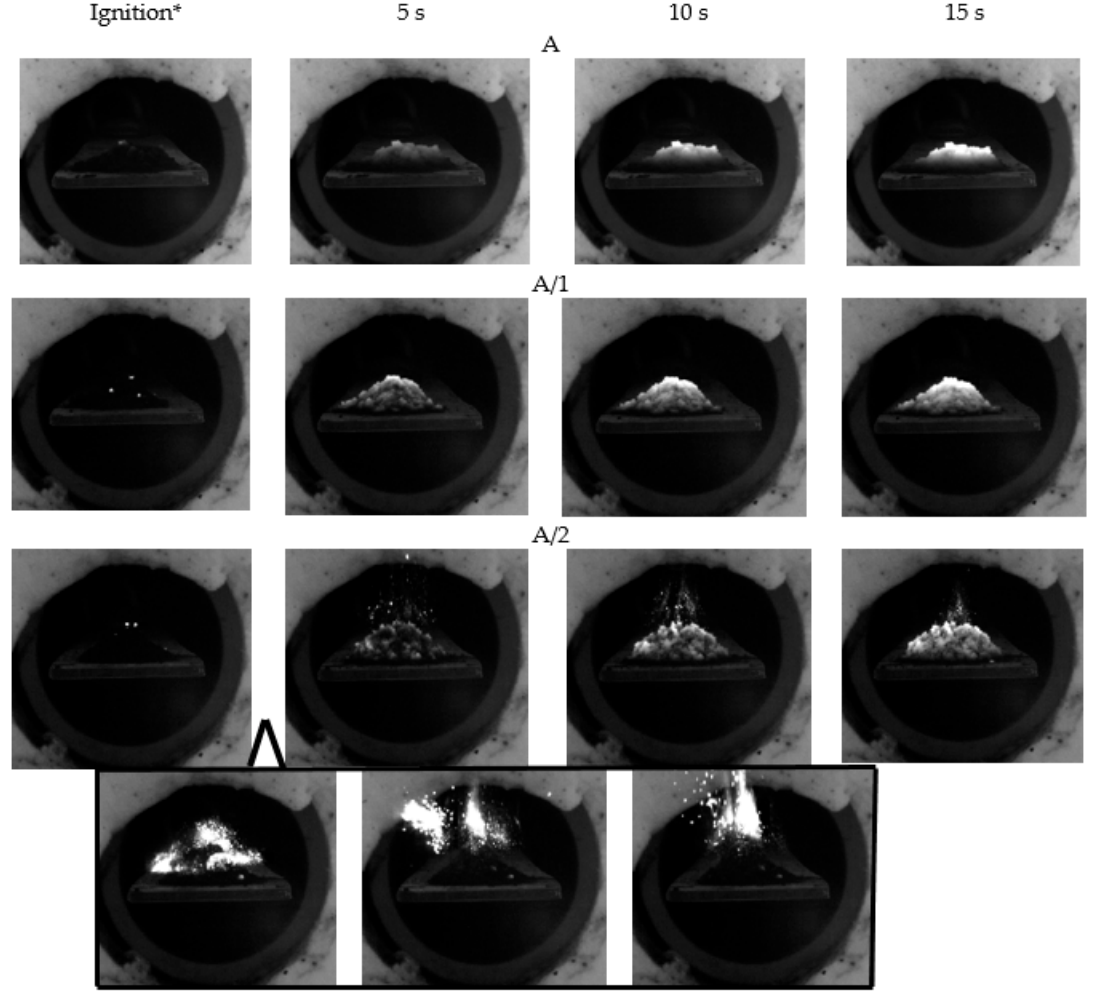
Figure 5. The ignition and subsequent combustion of the A ‐ series samples at a heating